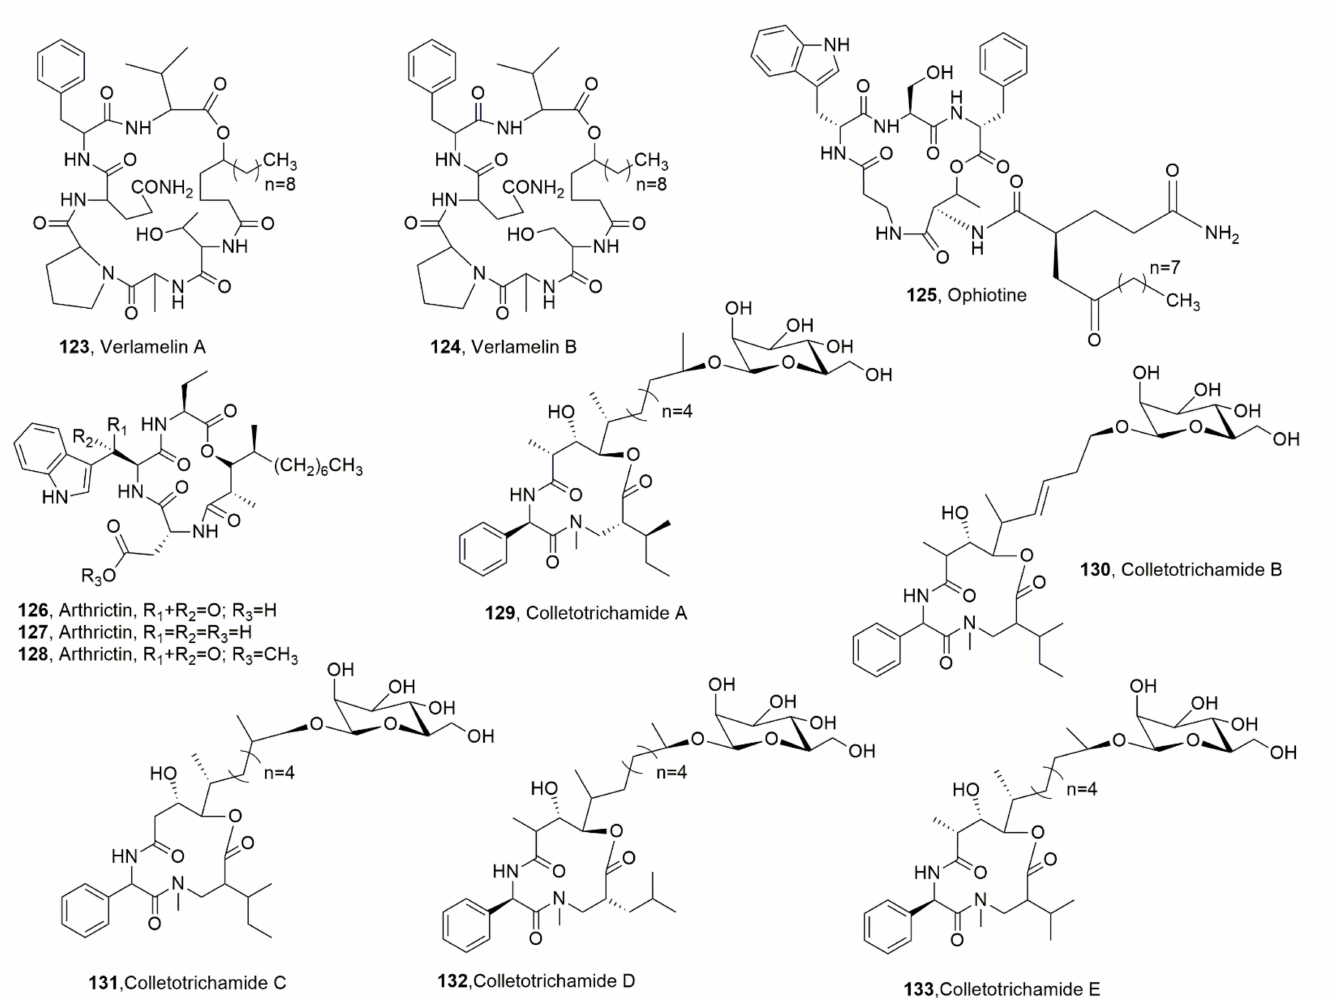
Figure 14. Lipodepsipeptide produced by Lecanicillium sp. ( 123 and 124 ), Ophiosphaerella genus ( 125 – 128 ), and Colletotrichum gloesporioides ( 129 – 133